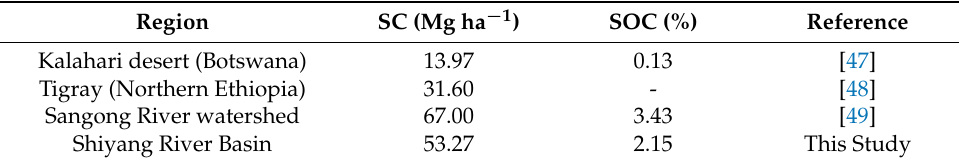
Table 2. Soil carbon storage in the Shiyang River Basin compared to other sites